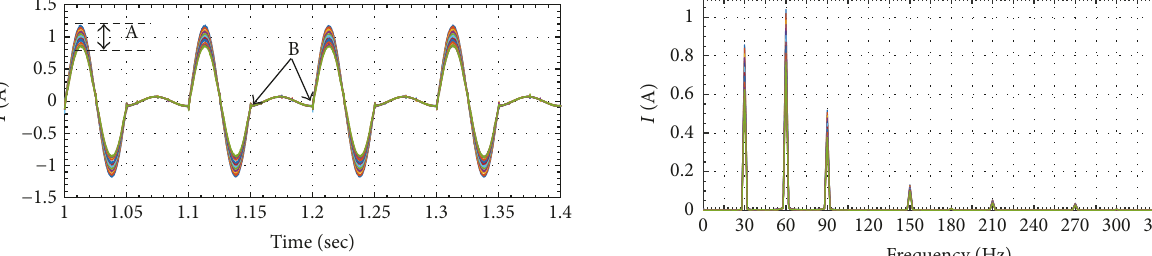
Figure 8: FFT magnitude for output current waveforms of microin- verter during burst mode (1 charging cycle) at different